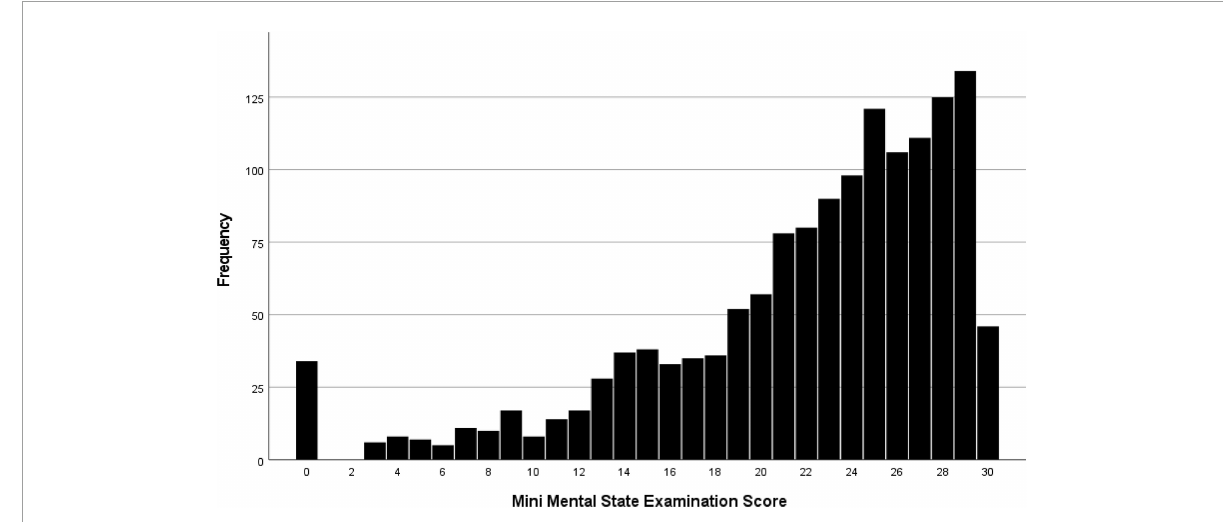
FIGURE1 Distribution of the Mini-Mental State Examination score in the Ural Very Old Study.